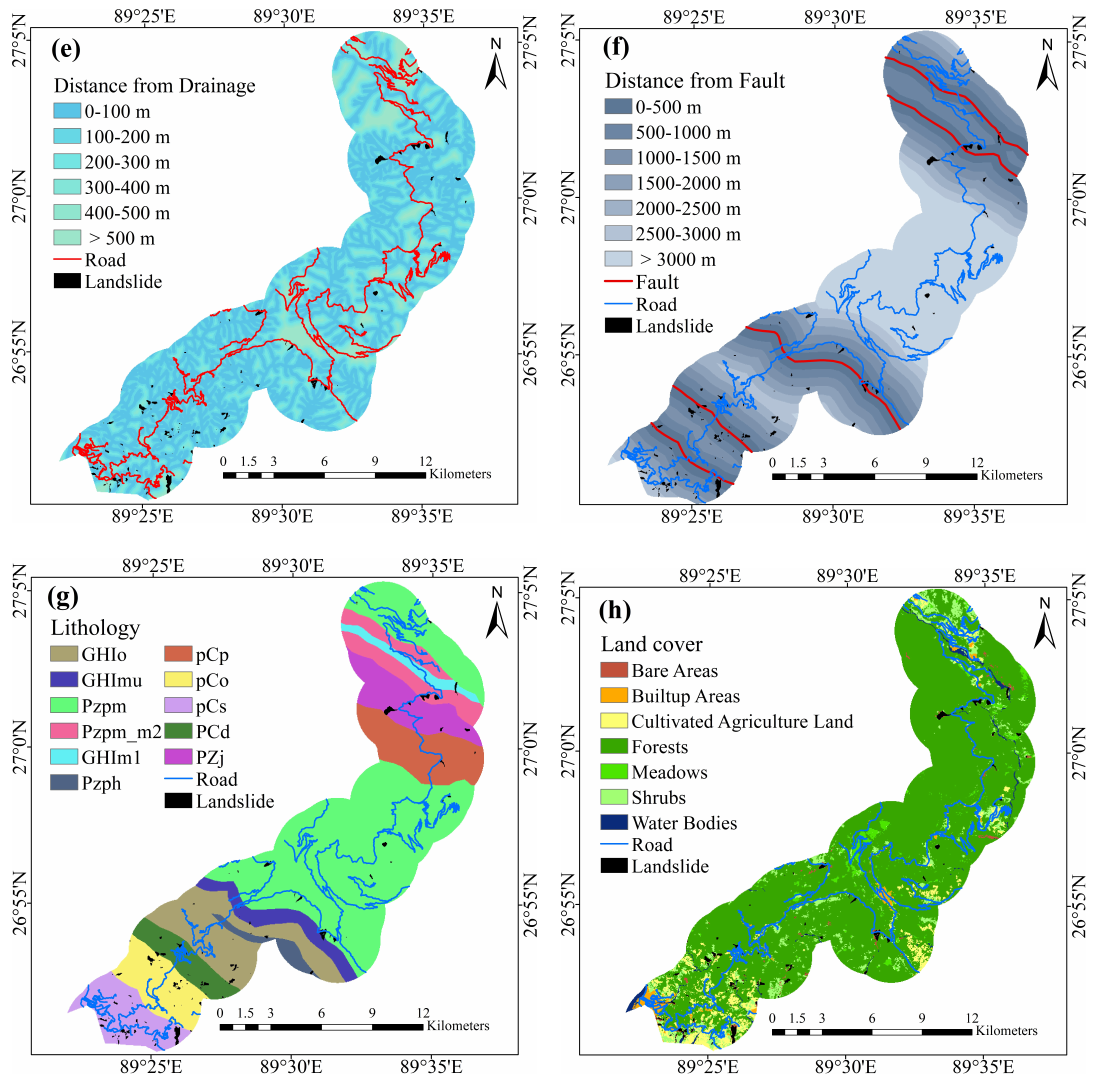
Figure 4. Landslide causal factor maps showing the different classes: ( a ) slope angle, ( b ) slope aspect, ( c ) elevation, ( d ) distance to road, ( e ) distance to drainage, ( f ) distance to fault, ( g ) lithology as described in Table 1, and ( h ) land